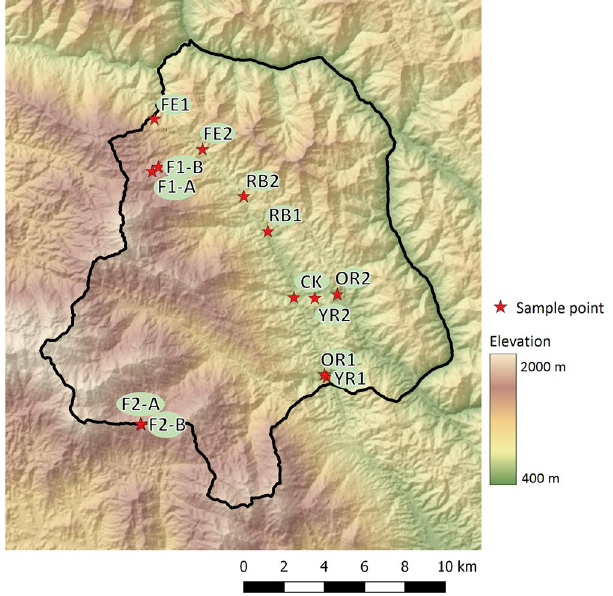
Figure 1. Map of the NRWNNR, showing sample (plot) locations. YR1 = Man-Dian Village (young rubber plantation), YR2 = Man-Fei Village (young rubber plantation), OR1 = Man-Dian Village (old rubber plantation), OR2 = Man-Fei Village (old rubber plantation), FE1 = Guo-Men Mountain (forest edge), FE2 = Ban-Qian-Di (forest edge), RB1 = An-Ma-Xin-Zhai (grassland by river bank), RB2 = Da-Nuo-You (shrubland by river bank), F1-A = Xiao-Nuo-You-Shang-Zhai (forest), F1-B = Xiao-Nuo-You-Shang-Zhai (forest), F2-A = Beng-Gang (forest), F2-B = Beng-Gang (forest), CK = Na-Ban research station. For more information on the location, geography and land use of NRWNNR and Xishuangbanna, see refs 36, 74. Background image: hillshade layer derived from SRTM elevation model. The map was produced using QGIS 2.14.5 75